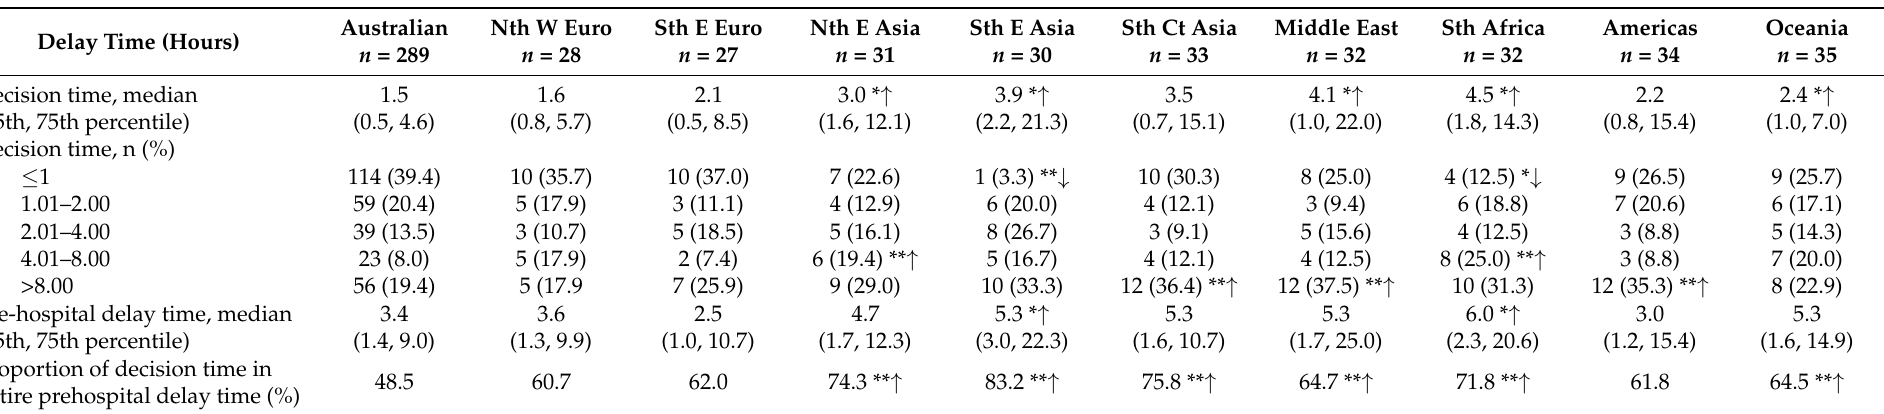
Table 3. Comparisons of decision times and prehospital delay times between ethnic